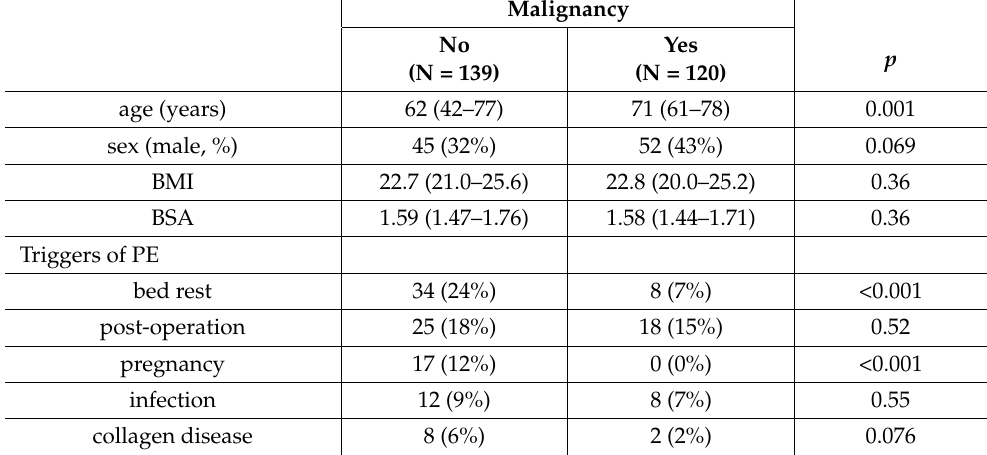
Table 2. The baseline characteristics of the study